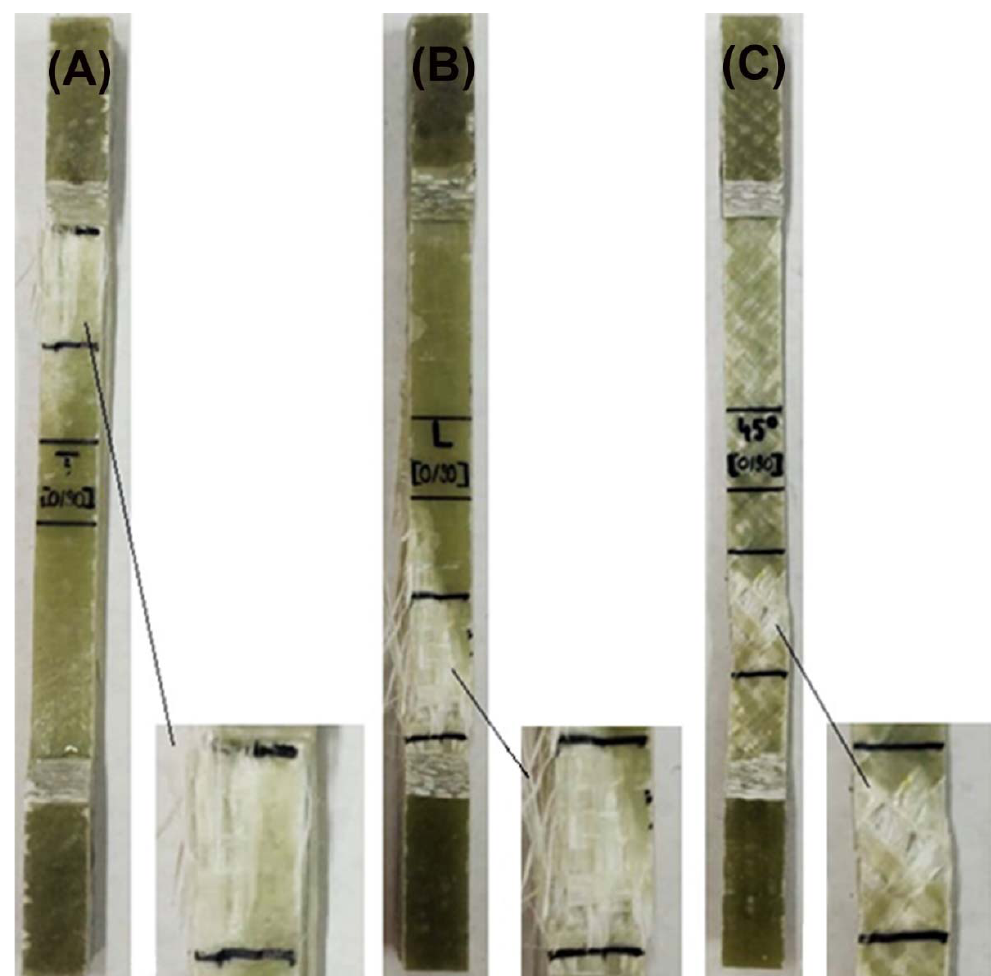
Figure 3. Typical failure modes of GFRP laminates: ( A ) transversal, ( B ) longitudinal, and ( C ) oriented at 45°.